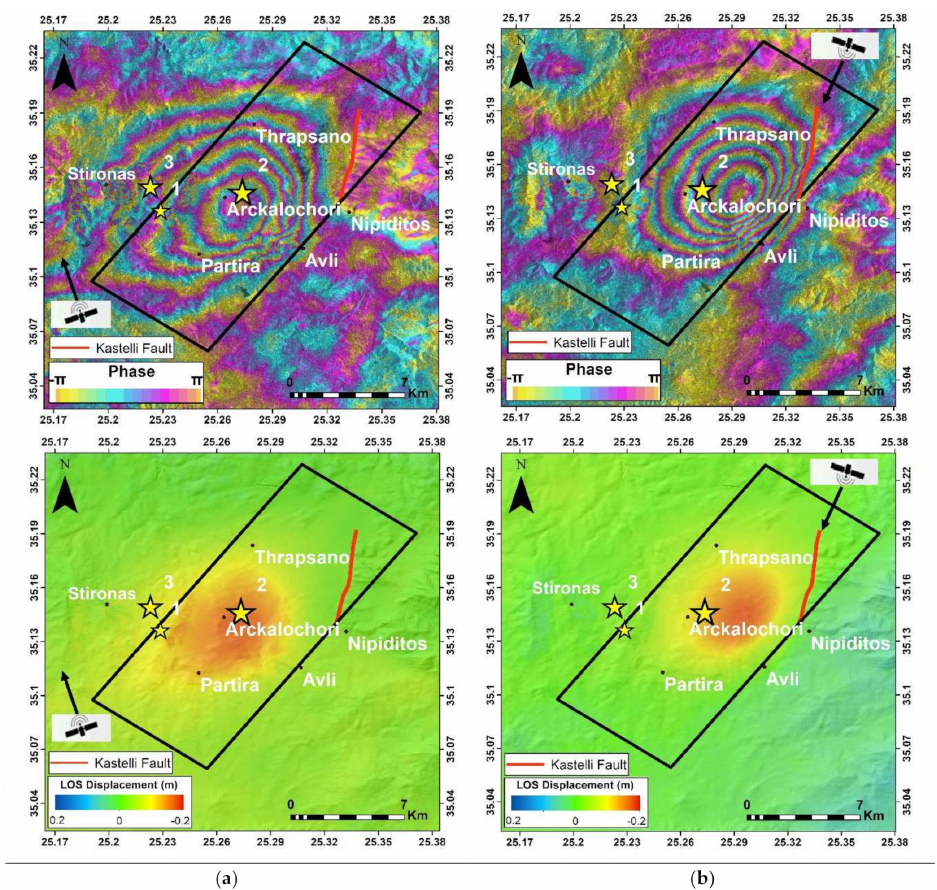
Figure 5. Wrapped interferograms (up) and LOS displacement maps (down) in ascending ( a ) and descending ( b ) geometries for the 27 September 2021 earthquake. Symbol key: red line illustrates the surface exposure of Kastelli Fault (KF in Figures 2 and 4); rectangle shows the surface projection of the geodetically determined fault plane (see Section 3.2); stars show epicenters of the largest foreshock of 24 July 2021 (1), mainshock of 27 September 2021 (2), largest aftershock of 28 September 2021 (3); black dots illustrate positions of